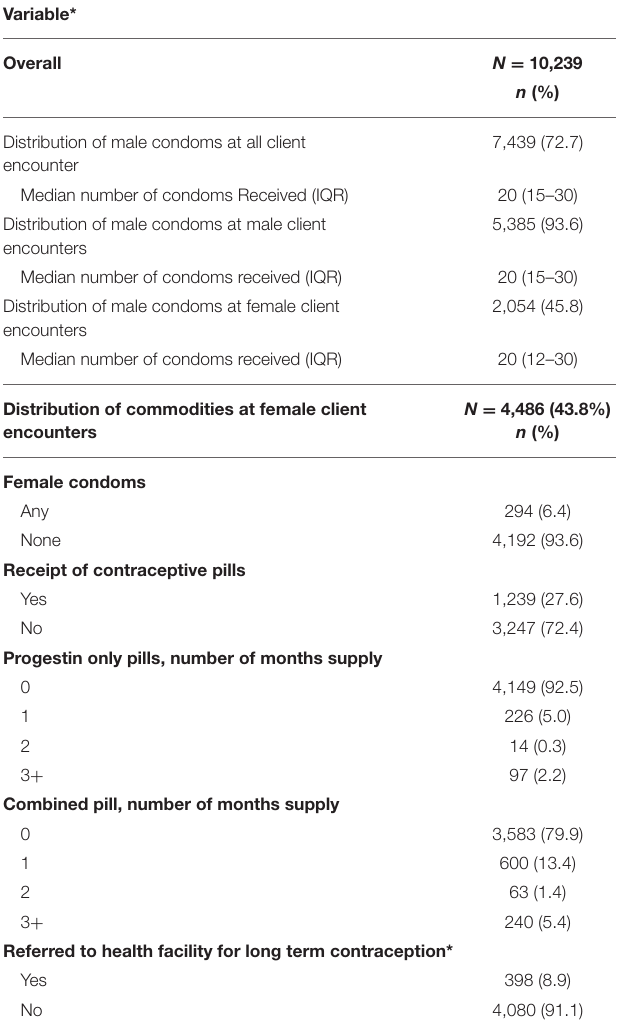
TABLE 2 | Encounter-level distribution of commodities from April 2015–May 2016, N =